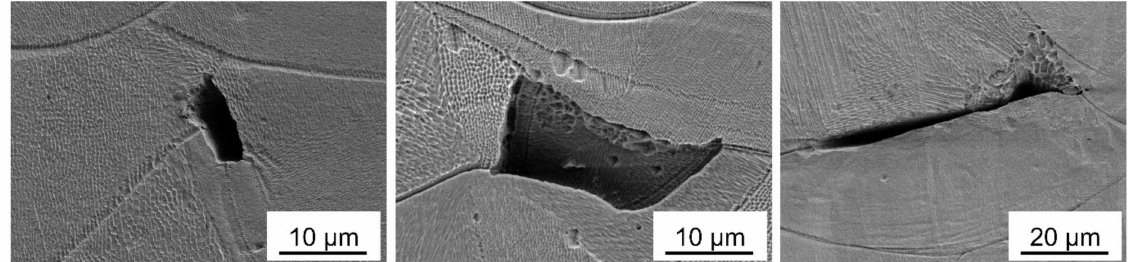
Figure 11. Detail on the morphology of lack of fusion flaws.